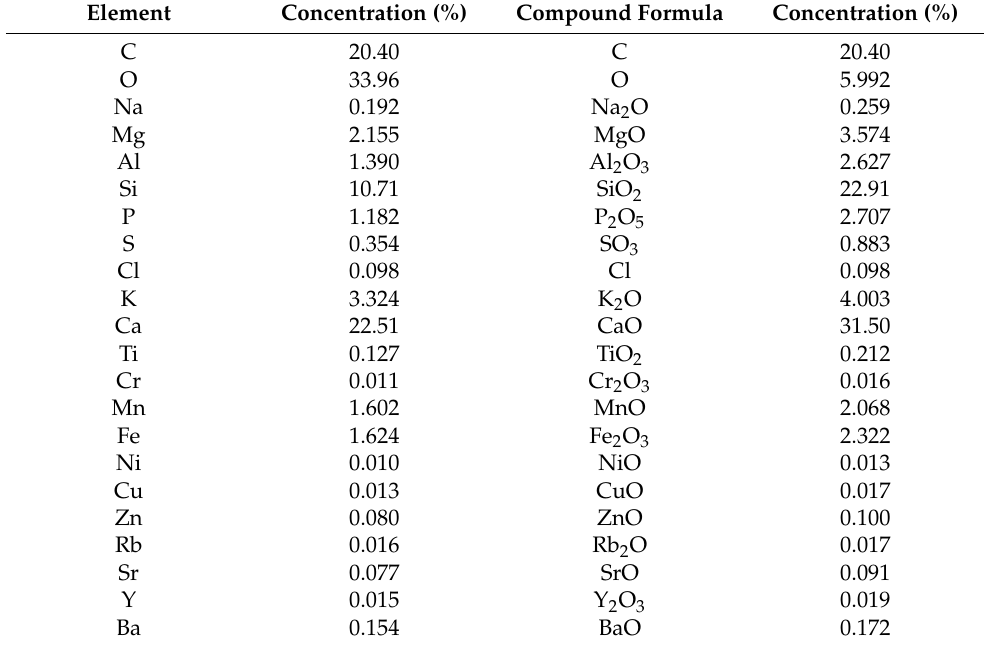
Table 1. Chemical compositions of BFA. Element Concentration (%) Compound Formula Concentration